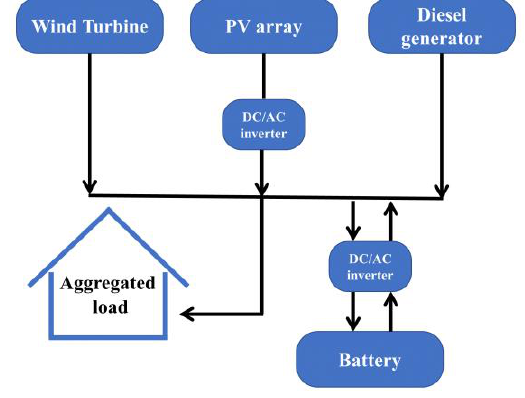
Figure 3. Schematic representation of the microgrid system.